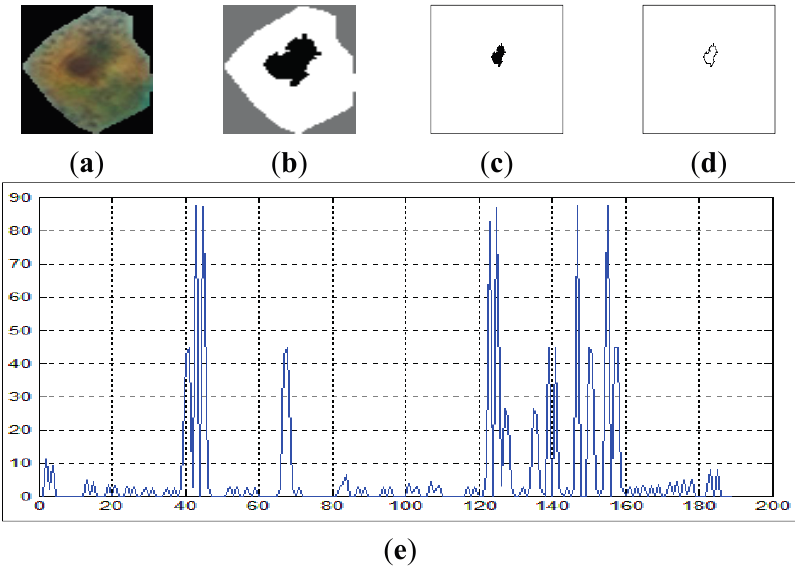
Figure 8. The curvature extraction of a malignant cell. ( a ) sputum cell; ( b ) nucleus and cytoplasm segmentation; ( c ) nucleus extraction; ( d ) nucleus boundary and ( e ) reflects the curvature plot for the image in ( d